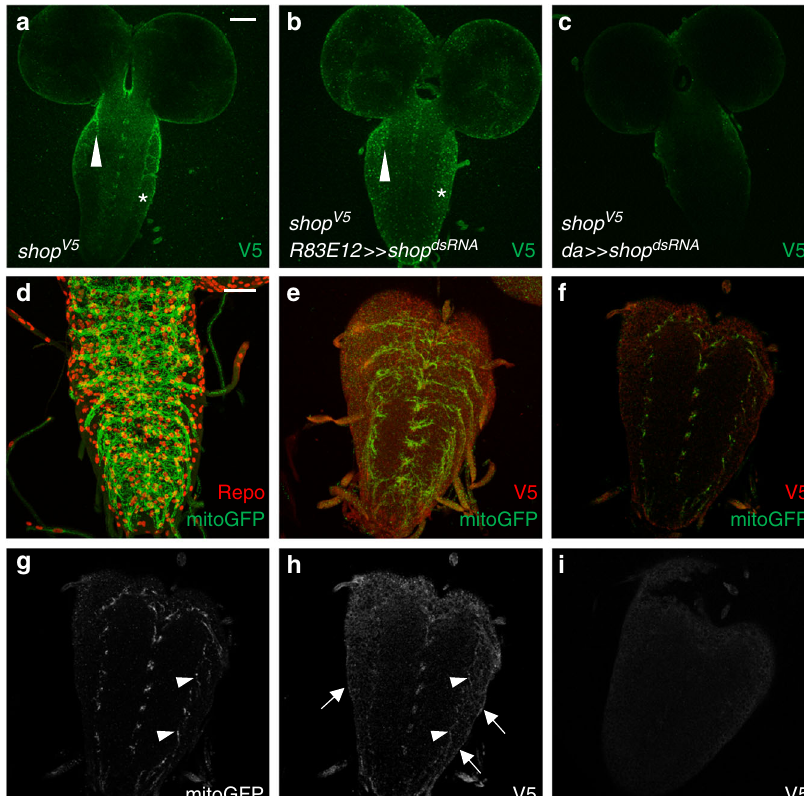
Fig. 5 Shopper localizes to mitochondria of the ensheathing glia. a Shopper V5 expression (green) in a third-instar larval brain. Note the enrichment of Shopper expression in the ensheathing glia (arrowhead) and the weak expression in the CNS cortex (asterisk). b Upon expression of shopper dsRNA in all ensheathing glial cells, Shopper expression cannot be detected in the ensheathing glia anymore (arrowhead), but the expression in the cortex glia remains (asterisk). c Upon ubiquitous expression of shopper dsRNA using the da-Gal4 driver Shopper expression is abolished. d The organization of mitochondria in ensheathing glial cells in third-instar larval brains as revealed by expression of UAS-mitoGFP using R83E12-Gal4 (green). Repo staining (glial nuclei, red) and HRP staining (neuronal membranes, blue) are shown as well. Note that this is a projection of a confocal stack of a paraformaldehyde (PFA)- fi xed specimen. e Endogenous Shopper expression as revealed by expression of an V5-tagged Shopper protein (red) in an animal expressing UAS-mitoGFP in the R83E12- Gal4 pattern (green). Note that detection of V5 only works after fi xation with Bouin ’ s fi xative. f – h Single focal planes of the same stack as in ( e ); staining as indicated. Enrichment of Shopper expression can be detected in neuropil-associated glial cells (arrowheads) and the surface glial cells (arrows). i Control staining of a wild-type nervous system for V5 expression following Bouin ’ s fi xation. Note the high background in the CNS cortex. Scale bars are 20 µ